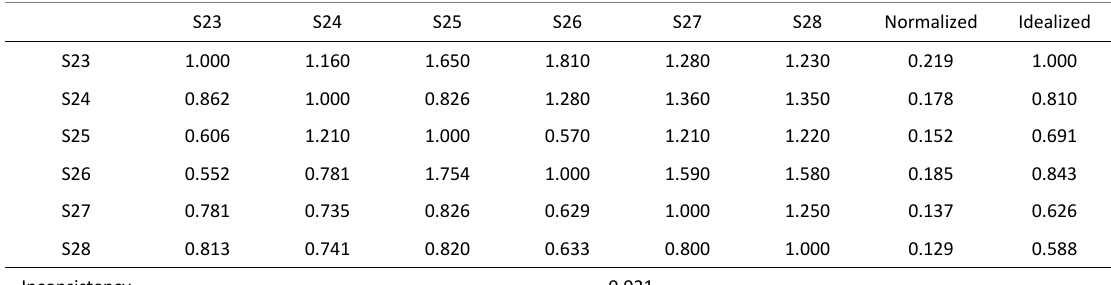
Table 10. Pairwise comparison matrix of economic sub-criteria Table 10: Pairwise comparison matrix of economic